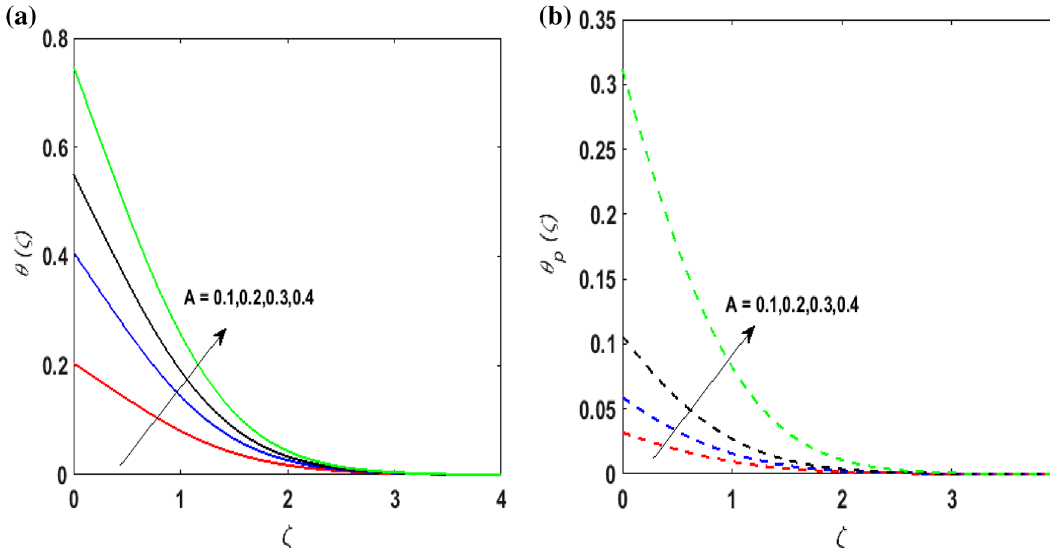
Figure 10. ( a ) θ(ζ) for various A . ( b ) θ p (ζ) for various A .